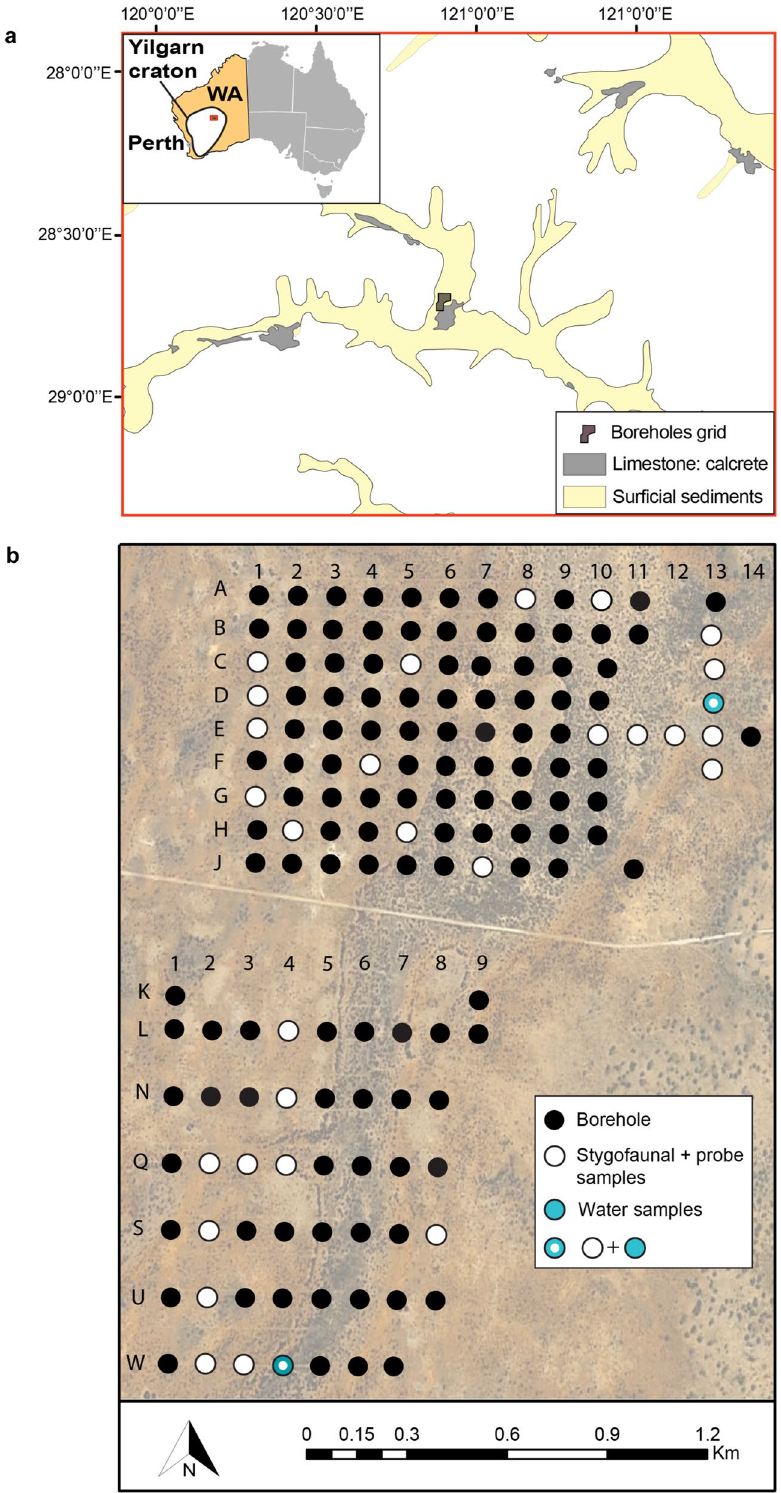
Figure 1. Map of the Sturt Meadows calcrete. ( a ) Location within the Yilgarn craton region and detailed paleodrainages/cacretes in the area and ( b ) the grid map showing the location of the boreholes sampled for stygofauna together with probe samples, water samples (in light blue) and the combination of both. Map was produced in ArcGIS Desktop 10.6 79 and edited in Adobe Illustrator 25.0 80